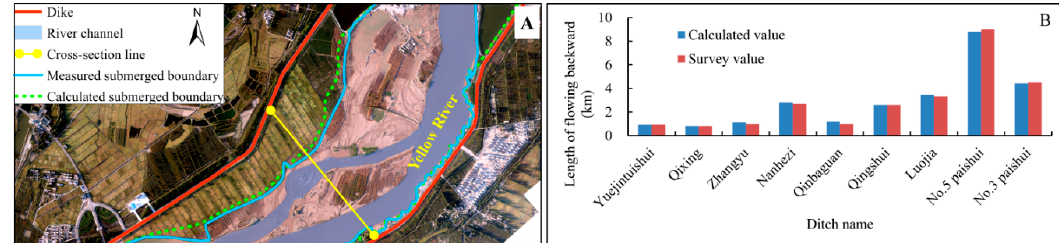
Figure 6. Validation of the moderate frequent flooding hazard assessment results based on the aerial images: ( A ) Following the flooding events in 2012 and the survey data; ( B ) backward flowing in the